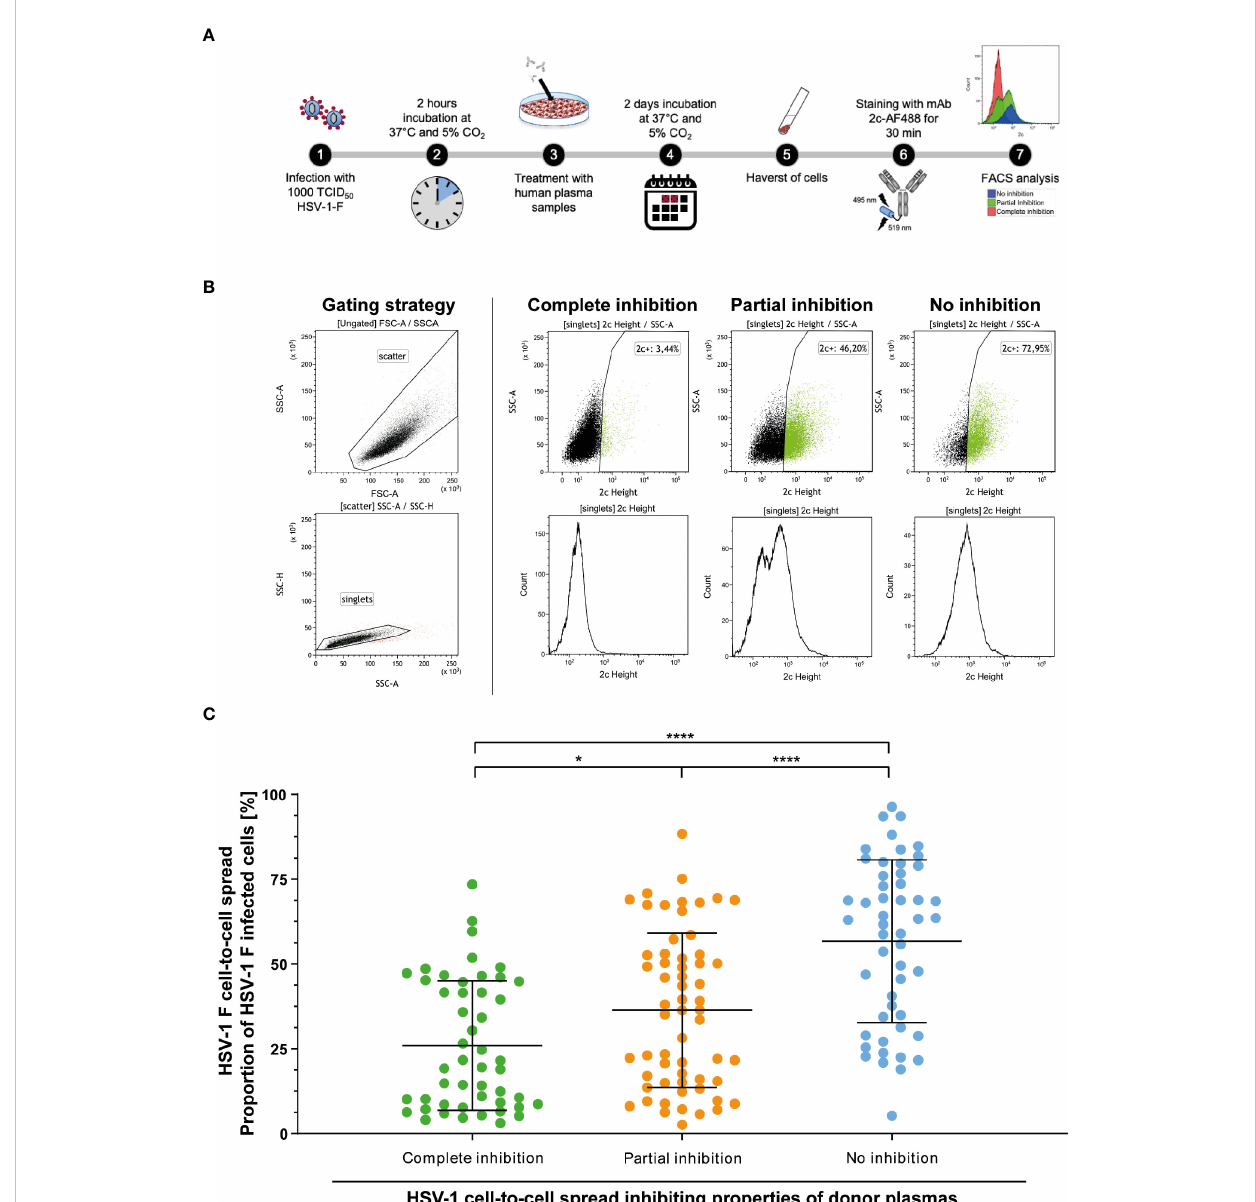
FIGURE 7 Assessment of the HSV-1 F cell-to-cell spread inhibition capacity of plasma samples against HSV-1. Plasma samples from blood donors who participated the retrospective survey (n = 158, complete inhibition group n = 47, partial inhibition group n = 58, and the no inhibition group n = 53) were re-tested for the inhibition of HSV-1 F cell-to-cell spread. (A) Vero cells were infected with 1000 TCID50 HSV-1 F for two hours and subsequently overlaid with plasma samples at a 40-fold dilution in cell culture medium. After two days of incubation, the cells were harvested and stained with a gB-speci fi c, Alexa Flour 488 labeled monoclonal antibody 2c for FACS analysis. (B) Gaiting strategy and representative plots from cell cultures treated with plasmas that showed complete, partial or no inhibition of the HSV-1 cell-to-cell spread in the initial screening (Figure 2). (C) Percentages of HSV-1 F positive Vero cells after treatment of HSV-1 F-infected cell cultures with donor plasmas from the indicated groups. The middle horizontal bars represent the mean values and the upper and lower bars the standard deviation of the mean (SD). Signi fi cant changes were statistically analyzed using the One-way ANOVA and indicated by asterisks (*p < 0.05, ****p <